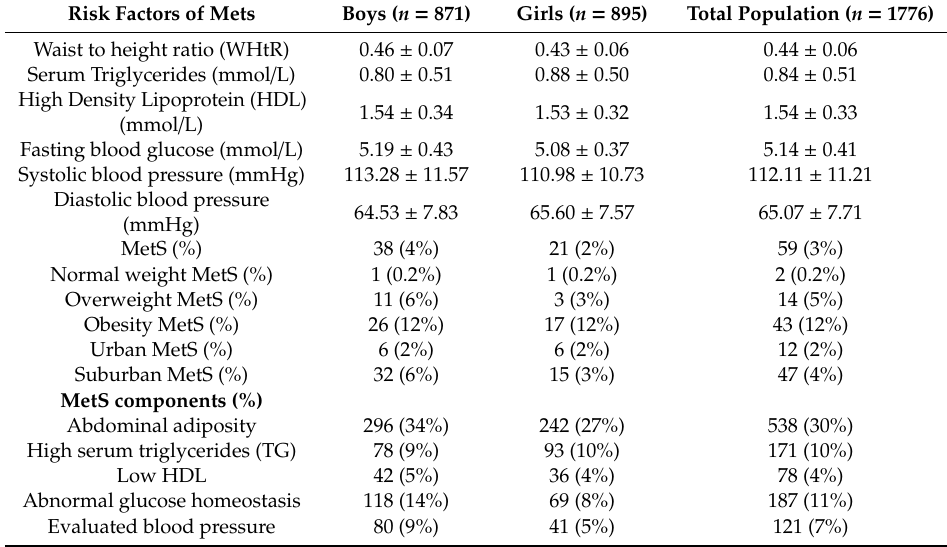
Table 2. Distribution of risk factors of MetS among